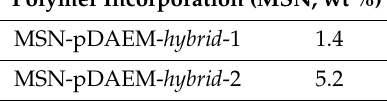
Table4. WeightfractionofpolymerintheMSNshellincorporatedbyhybridgrafting-tothenanoparticles (gRAFT- hybrid